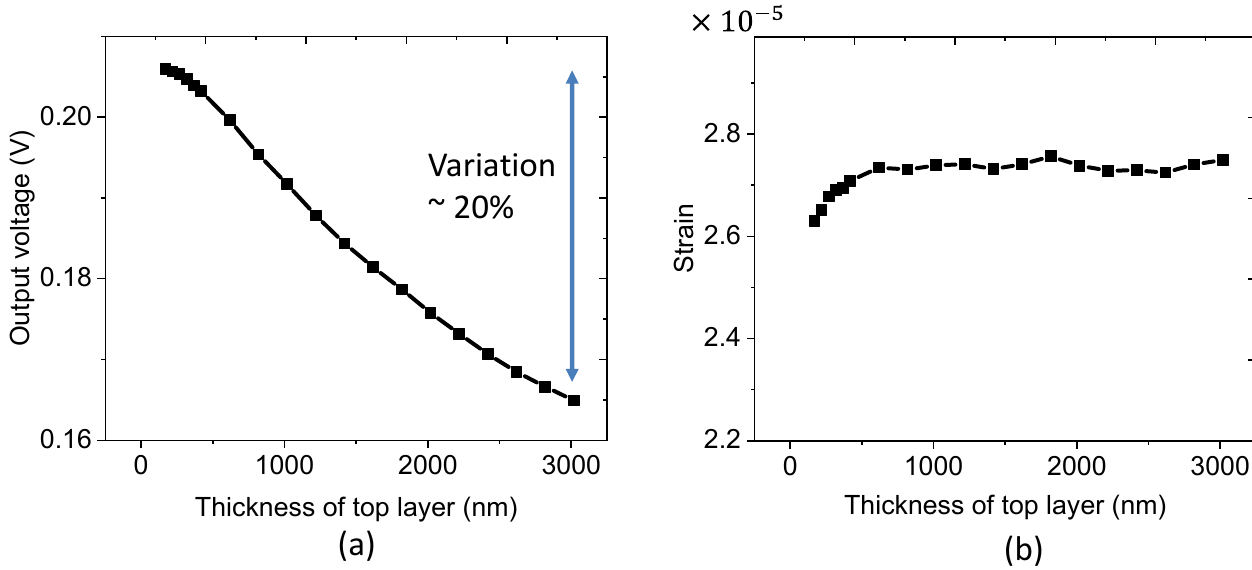
Figure 11. FEM simulation results of the effect of top layer thickness on the ( a ) generated output voltage, and ( b ) the strain of ZnO.